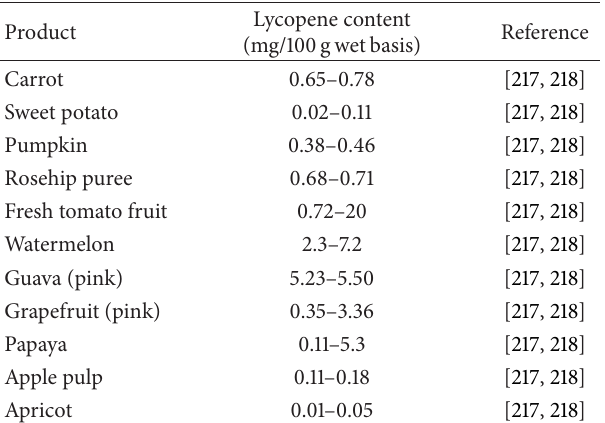
Table 11: Lycopene contents of different fruits and